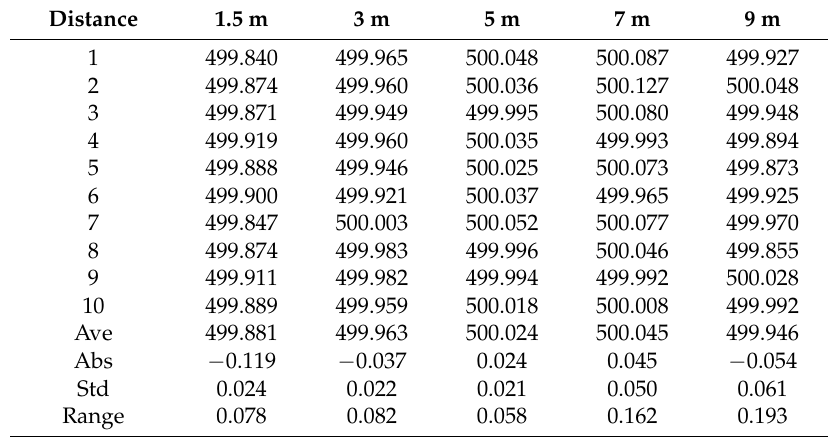
Table 4. Repeatability tests of measuring the length of a gauge block (in mm) at different